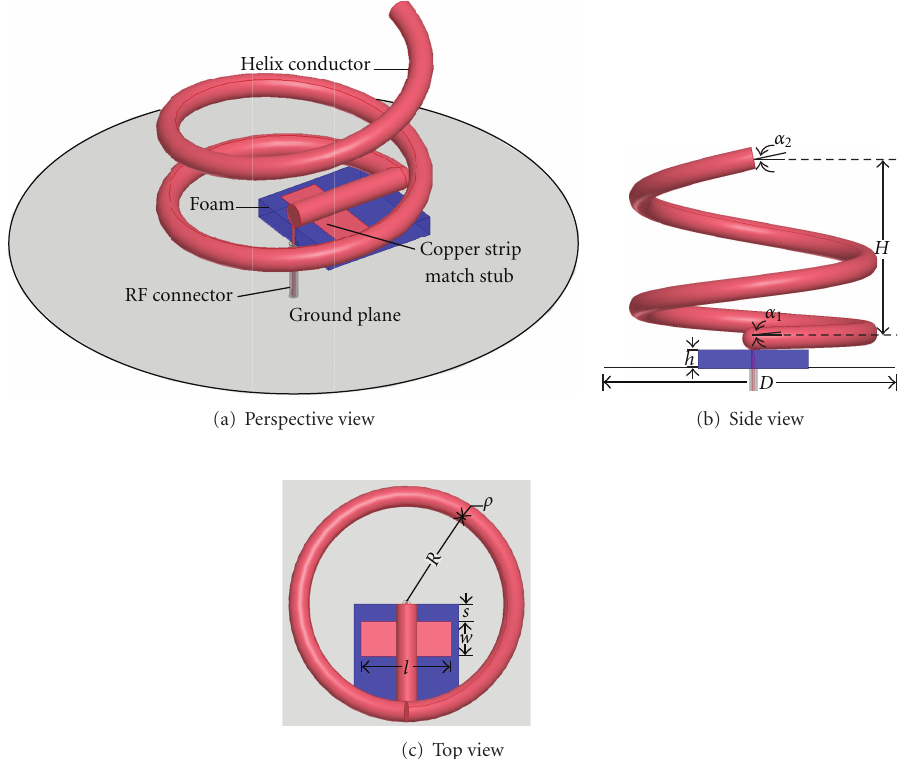
Figure 1: Antenna model